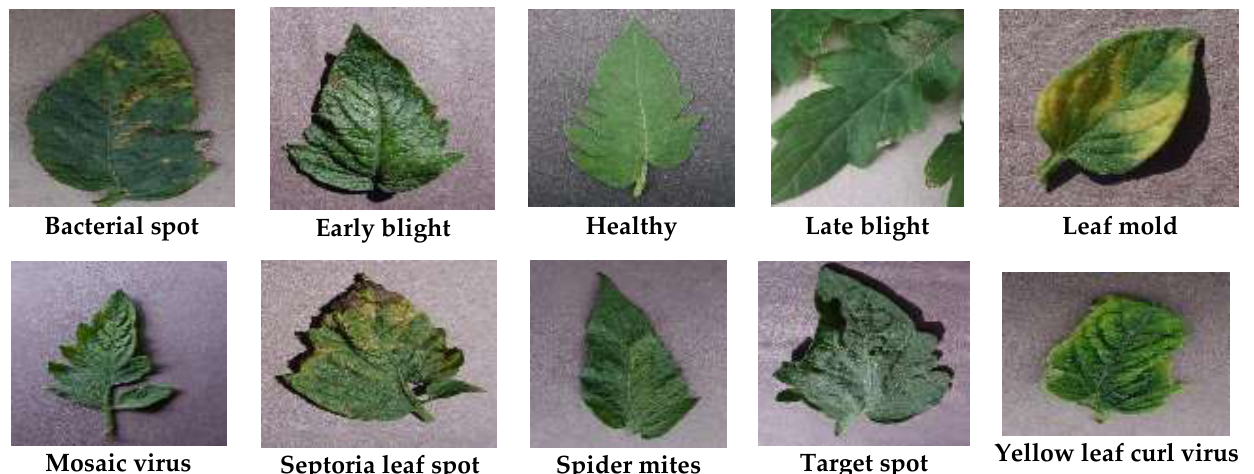
Figure 1. Different class sample images of tomato leaf dataset.